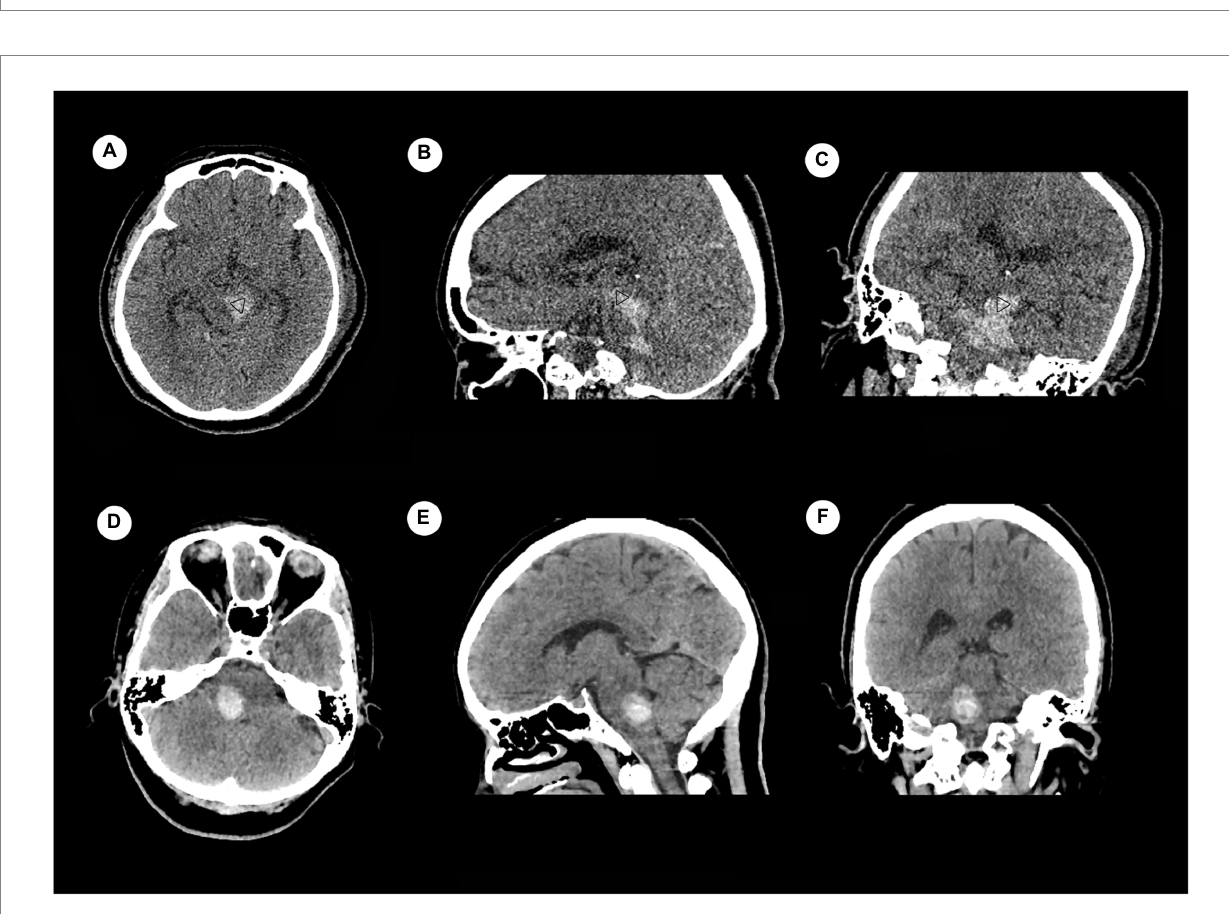
FIGURE 3 Examples of hemorrhage involving the midbrain (upper) and not involving the midbrain (lower) detected by craniofacial computer tomography (CT) scans. (A) Transverse view: Hematoma was present only in midbrain ( ▷ ). (B) Coronary view: Hematomas were present in midbrain ( ▷ ) and pons. (C) Sagittal view: Hematomas were present in midbrain ( ▷ ) and pons. (D) Transverse view: Hematoma was present only in pons. (E) Coronary view: Hematoma was present only in pons. (F) Sagittal view: Hematoma was present only in